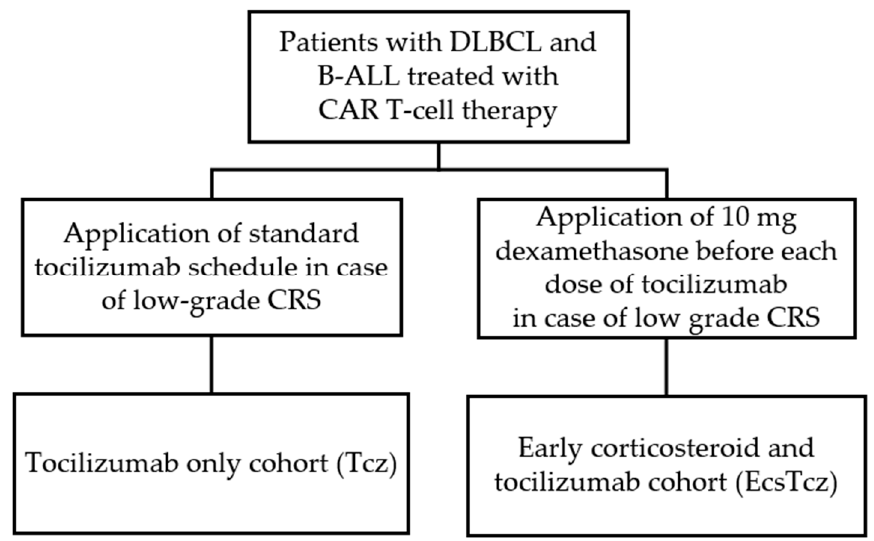
Figure 1. Schematic illustration of study design and patient cohorts. Abbreviations: B-ALL: B-cell acute lymphoblastic leukemia; CAR-T cell therapy: chimeric antigen receptor T-cell therapy; CRS: cytokine release syndrome; DLBCL: diffuse large B-cell lymphoma.